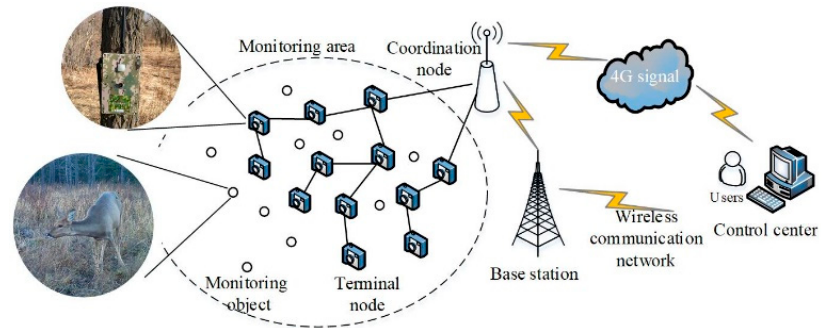
Figure 1. Wildlife monitoring system. Table 1. Parameters of wireless multimedia sensor network (WMSN) Node.